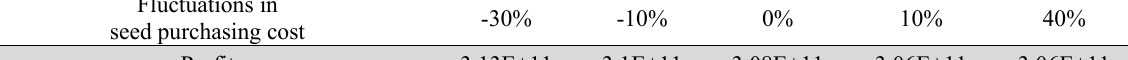
Total profit vs. fluctuations in seed purchasing cost Fluctuations in